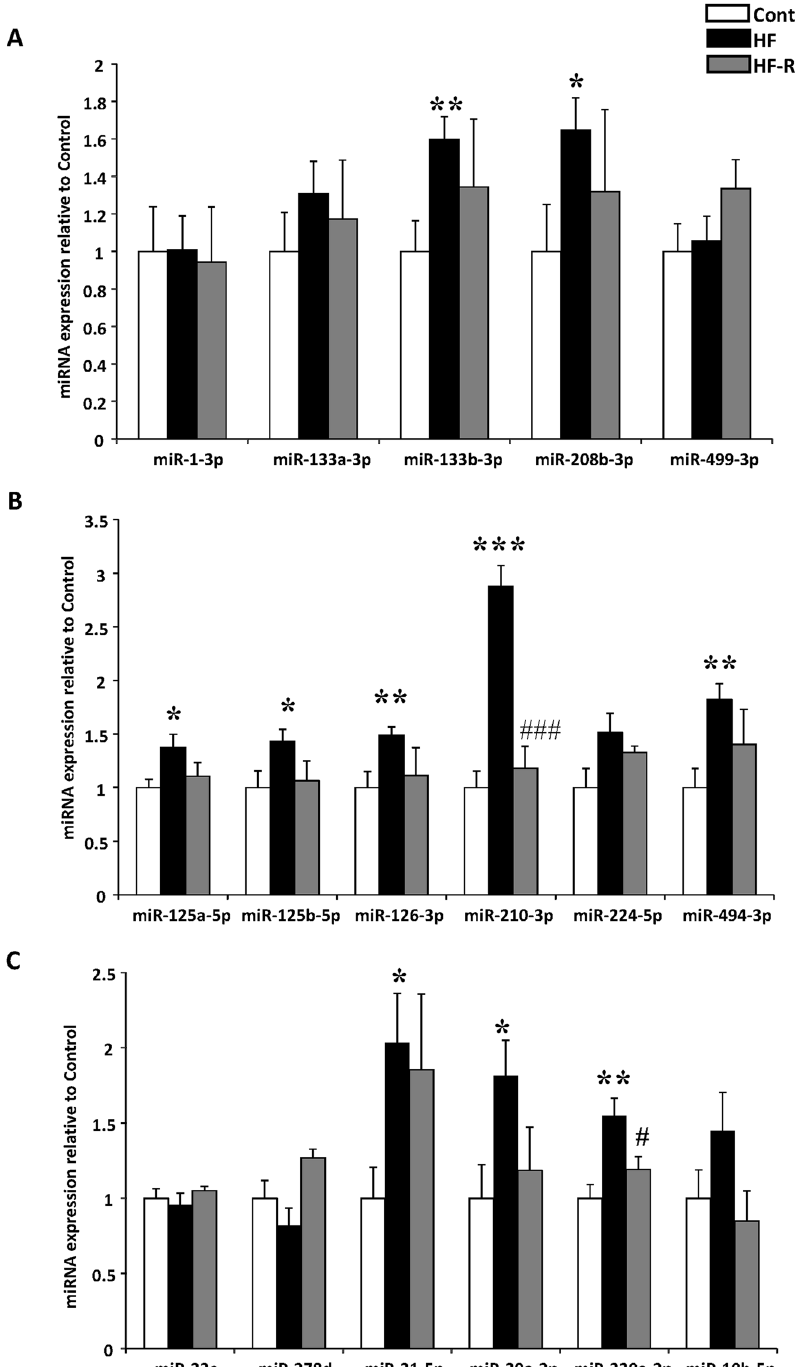
Figure 5. Stem-loop qPCR validation of miRNAs dysregulation. ( A ) Comparison of five cardiac enriched miRNAs in the 3 groups. ( B and C ) validation of 12 significantly dysregulated miRNAs detected by miRNA array. * p < 0.05, ** p < 0.01, *** p < 0.001 compared with Control; # p < 0.05, ### p < 0.001 compared with HF (Student’s t-test). Control (Cont, n = 13), Heart Failure (HF, n = 6) and Heart Failure-Recovery (HF-R, n =